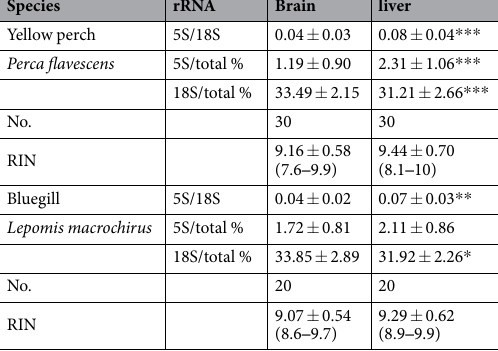
Table 1. Ribosome RNA (rRNA) percent of brain and liver in yellow perch and bluegill. 5S/18S, 5S–18S rRNA ratio; 5S/total %, 18S/total %, 5S or 18S rRNA percent relative to total RNA; * , ** , and *** indicate significance P value < 0.05, < 0.01, and < 0.001 respectively, between brain and liver in each species. RIN, RNA integrity number generated by Agilent 2100 Bioanalyzer. Data are presented as mean ± Standard